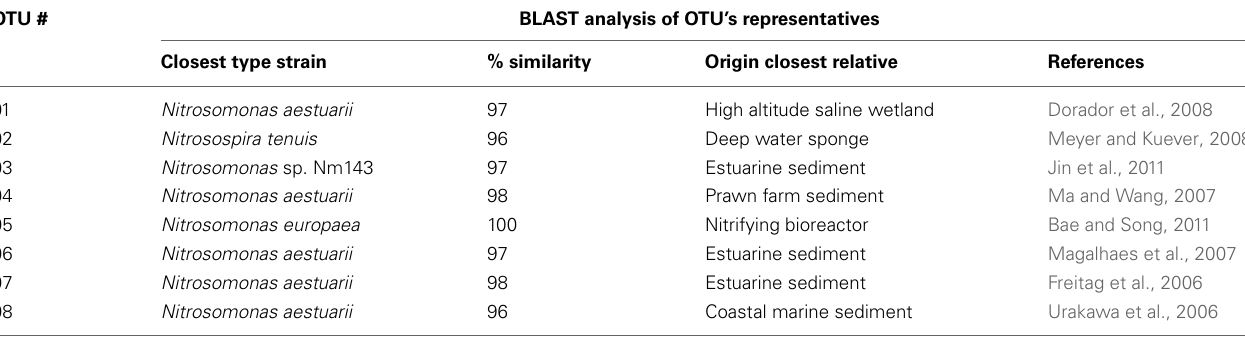
Table 1 | BLAST analysis of OTU’s representatives encountered in Black mangrove soils collected from the Indian River lagoon at North Hutchinson Island near Fort Pierce,